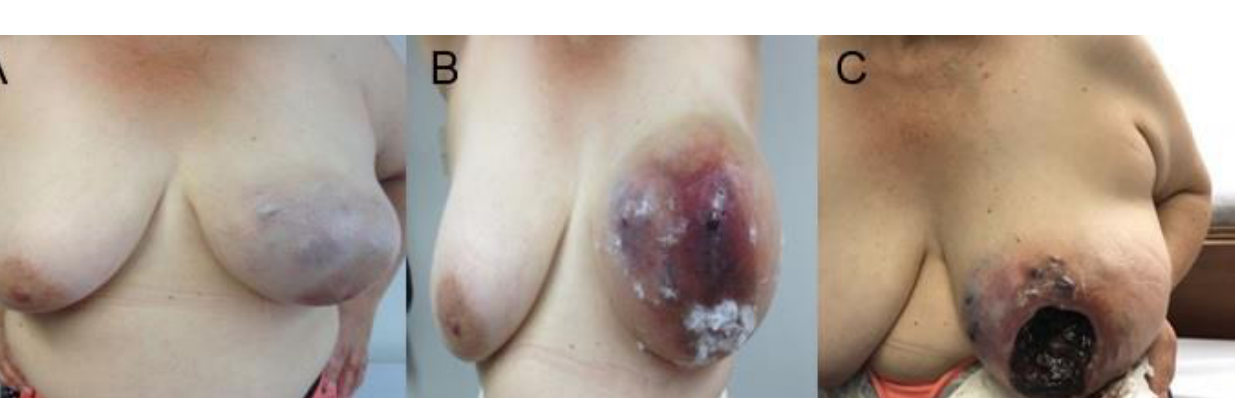
Figure 1. General outline of this study.